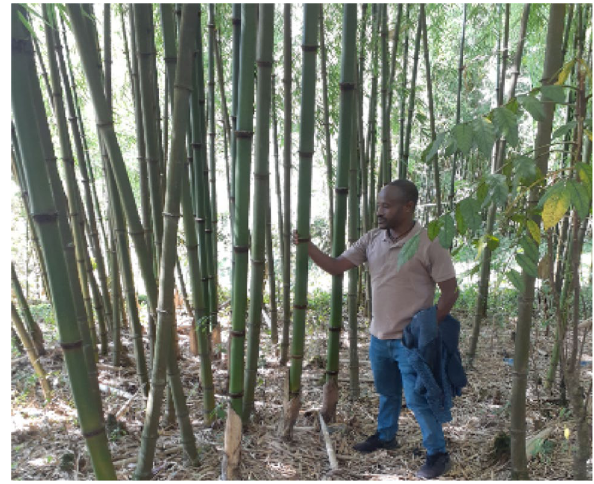
Fig. 1 Y.alpina bamboo plant in